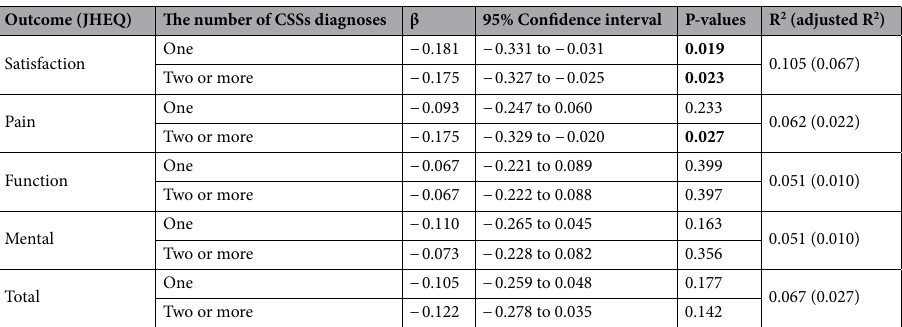
Table 4. Impact of the number of central sensitivity syndrome diagnoses on post-operative Japanese Orthopaedic Association Hip-Disease Evaluation Questionnaire scores in patients with hip osteoarthritis: multiple regression analyses (N = 173). All models were adjusted for sex, age, body mass index, duration of hip pain, and pre-operative visual analog scale for pain. Statistically significant P-values (< 0.05) are indicated in bold. CSS central sensitivity syndrome, JHEQ Japanese Orthopaedic Association Hip-Disease Evaluation Questionnaire, β standardized partial regression coefficient.